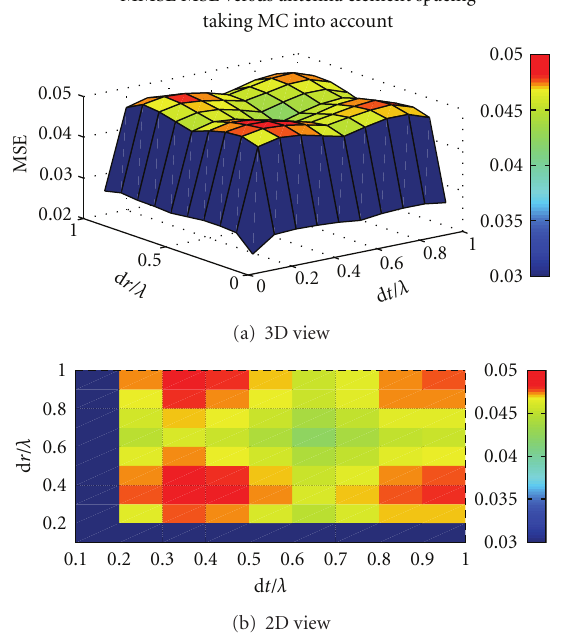
Figure 4: MMSE MSE versus transmitter and receiver antenna element spacing without taking MC into